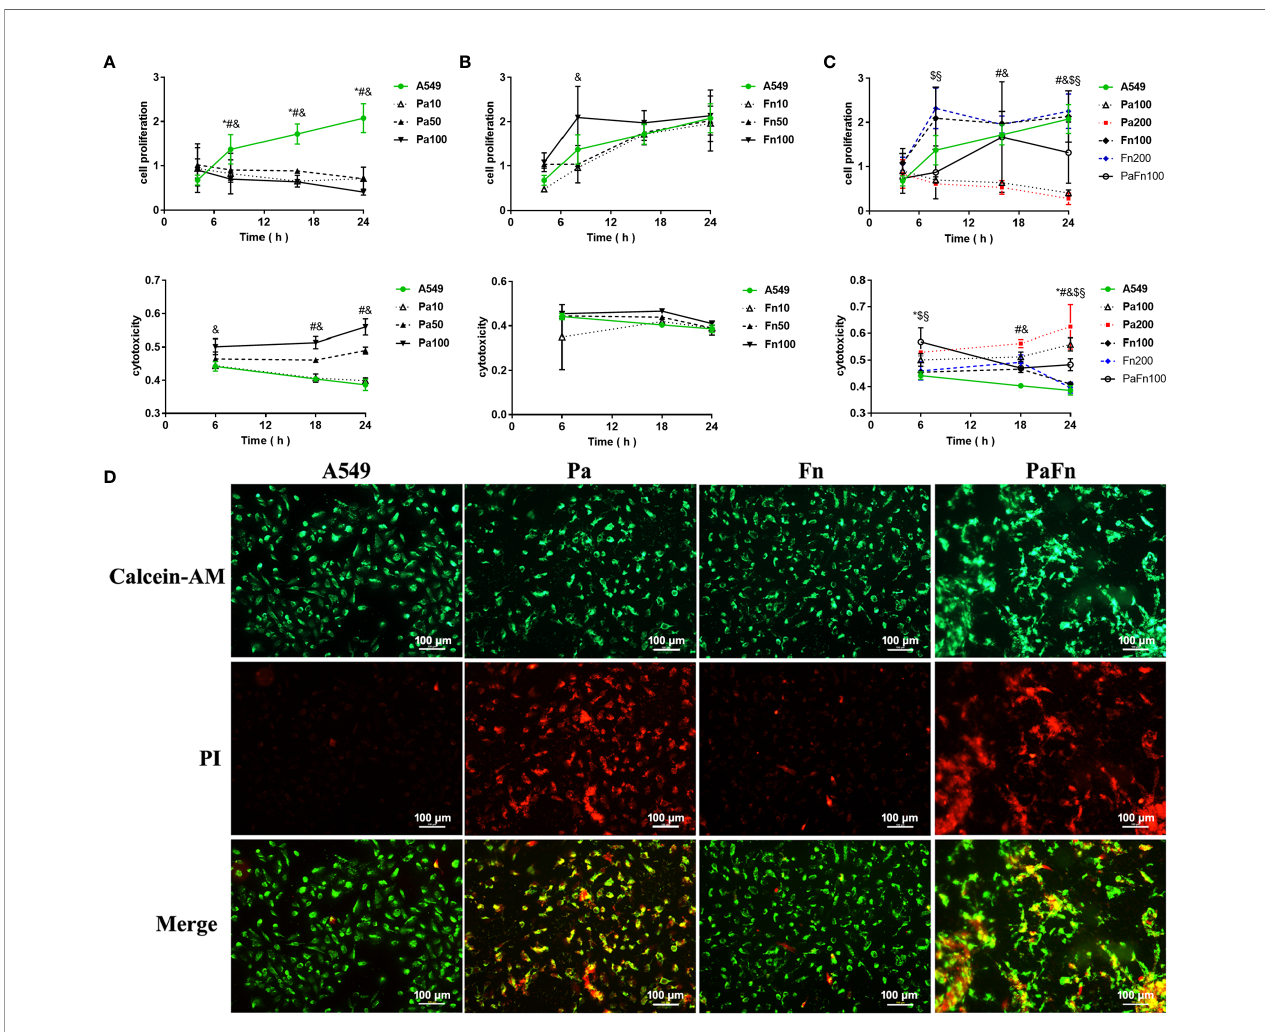
FIGURE 3 | The effect of P. aeruginosa and F. nucleatum on cellular proliferation and cytotoxicity. (A) The effect of P. aeruginosa on cell proliferation and cytotoxicity of pulmonary epithelial cells. A549 cells were infected with different MOI (10, 50, 100) of P. aeruginosa . * Pa10 compared with A549, # Pa50 compared with A549, & Pa100 compared with A549. (B) The effect of F. nucleatum on cell proliferation and cytotoxicity of pulmonary epithelial cells. A549 cells were infected with different MOI (10, 50, 100) of F. nucleatum . * Fn10 compared with A549, # Fn50 compared with A549, & Fn100 compared with A549. (C) The effect of the simultaneous infection of P. aeruginosa and F. nucleatum on cell proliferation and cytotoxicity of pulmonary epithelial cells. A549 cells were simultaneously infected with P. aeruginosa (MOI 100) and F . nucleatum (MOI 100), and the single P. aeruginosa or F. nucleatum infection groups (MOI 100, 200) were used as control. * A549 compared with PaFn100, # Pa100 compared with PaFn100, & Pa200 compared with PaFn100, $ Fn100 compared with PaFn100, § Fn200 compared with PaFn100. */#/&/$/§ P <0.05, statistics were achieved by analysis of variance followed by Dunnett ’ s multiple comparisons test. (D) Representative fl uorescence images of pulmonary epithelial cells infected with P. aeruginosa and F. nucleatum alone or together. A549 cells were infected with P. aeruginosa (MOI 100) and F. nucleatum (MOI 100) alone or together for 24 h. Pa, P. aeruginosa ; Fn, F. nucleatum